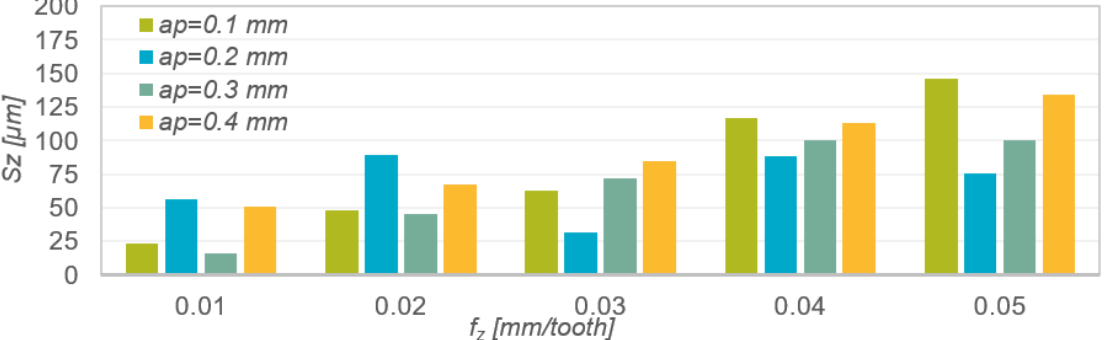
Figure 4. Results of measurements of the Sz roughness parameter as a function of feed per tooth f z and depth of cut a p .